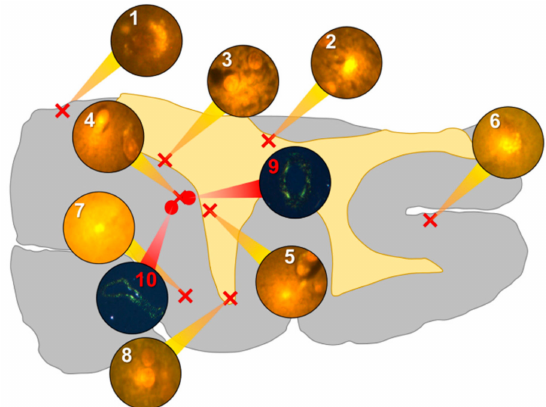
Figure 3. Schematic depicting a 5 µ m tissue section of the temporal lobe. White matter and grey matter are highlighted yellow and grey, respectively. Lumogallion-reactive aluminium was identified through sequential scanning of a 5 µ m tissue section with positive bright orange fluorescence denoted by red crosses (regions 1–8). On an adjacent serial section, Congo red positive regions showing apple-green birefringence under polarised light identified amyloid, denoted by red circles (regions 9 and 10).